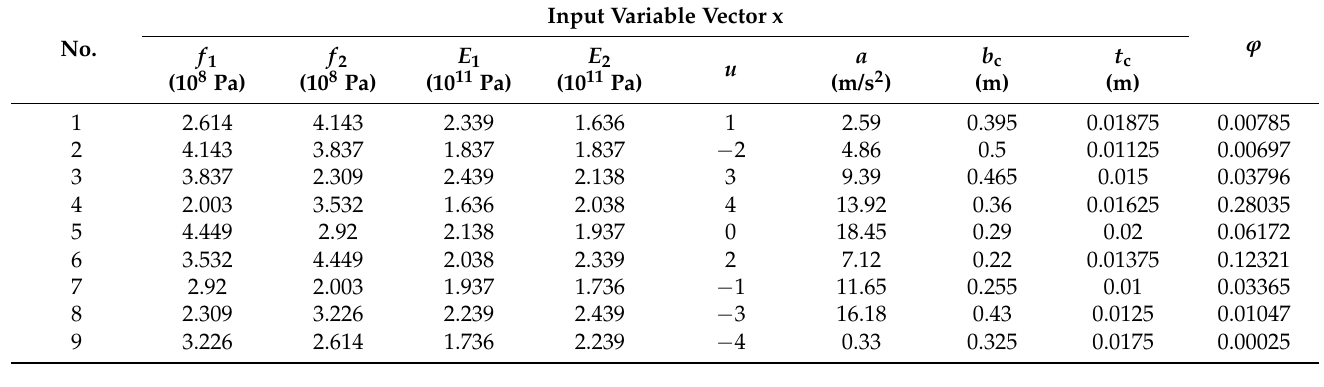
Table 3. Initial DoE of the EDP in Example 1.